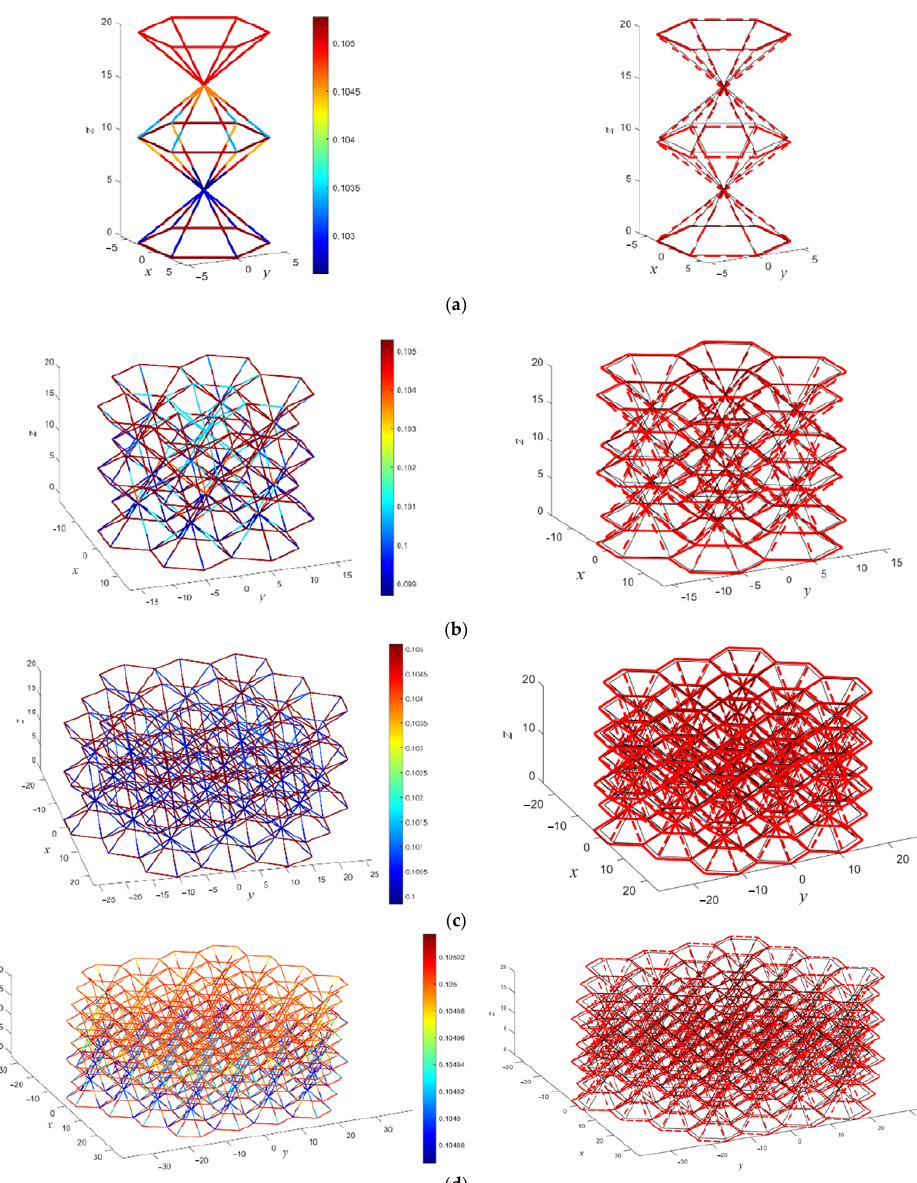
Figure 9. Schematic illustration of optimized results and thermal deformation of the hexagonal hourglass lattice: ( a ) N = 0, CTE = 5.727 × 10 − 7 m/(m · K); ( b ) N = 1, CTE = 5.457 × 10 − 7 m/(m · K); ( c ) N = 2, CTE = 5.433 × 10 − 7 m/(m · K); ( d ) N = 3, CTE = 5.202 × 10 − 7 m/(m ·